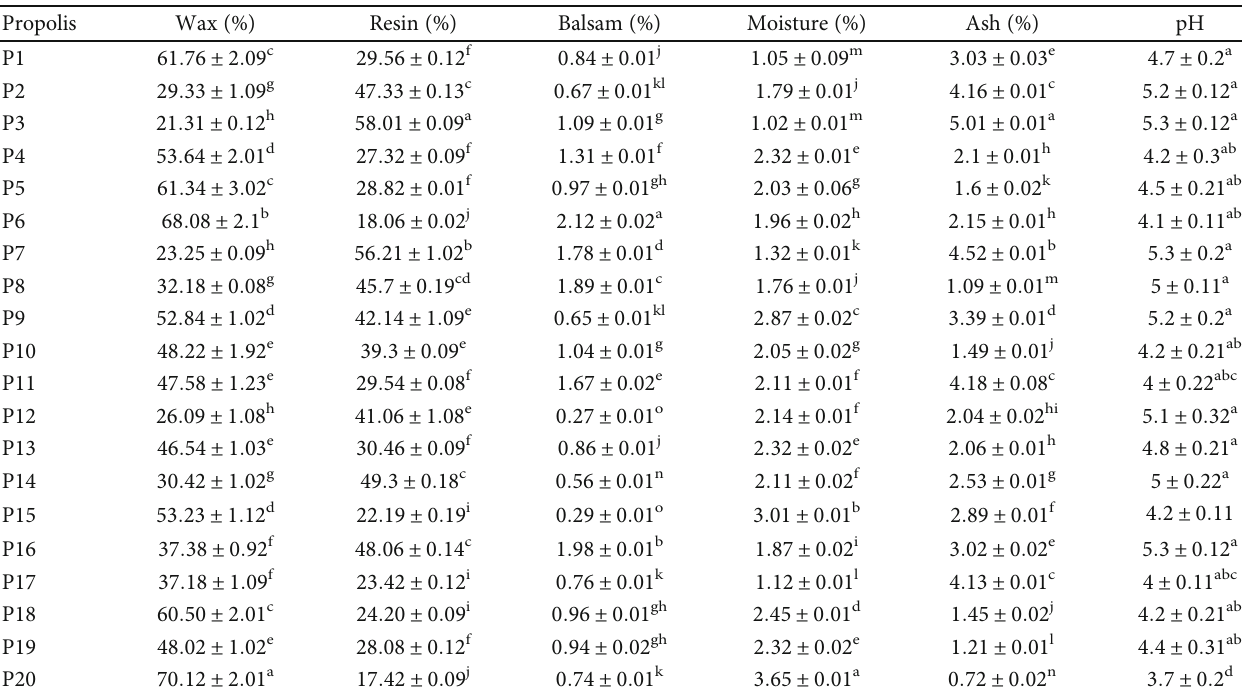
Table 2: Physicochemical characterization of the analyzed propolis